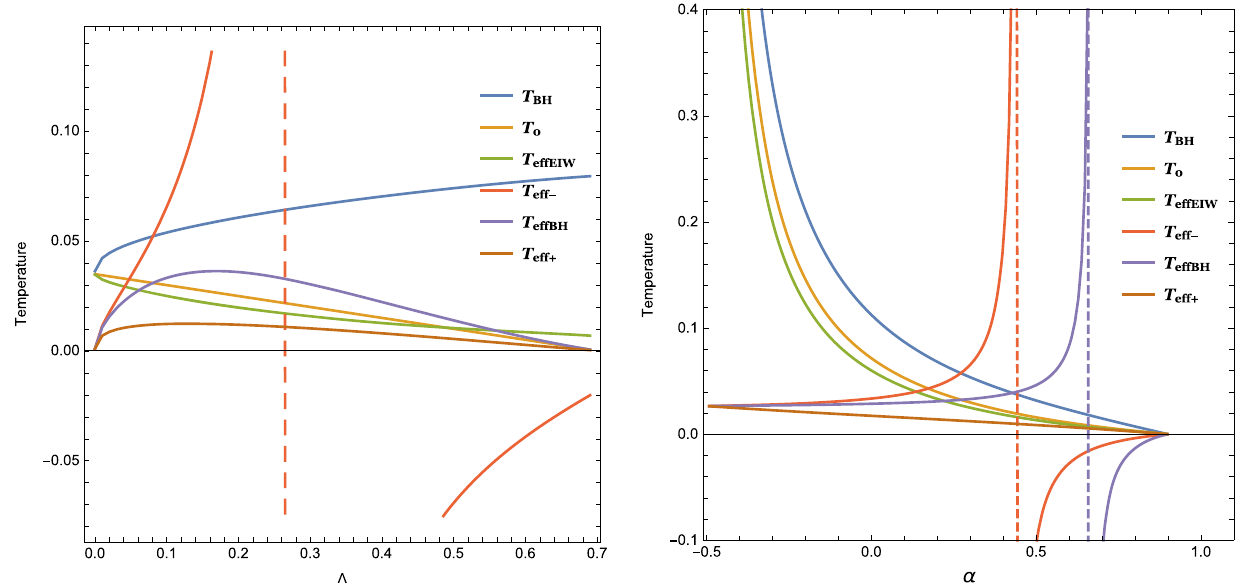
Fig. 5 The dependence of the effective temperatures of the black hole (2.4) on (cid:3) (left, with fixed α = 0 . 3) and α (right, with fixed (cid:3) = 0 . 1). The extremal black hole satisfies α + (cid:3) = 1 and α > − 0 .